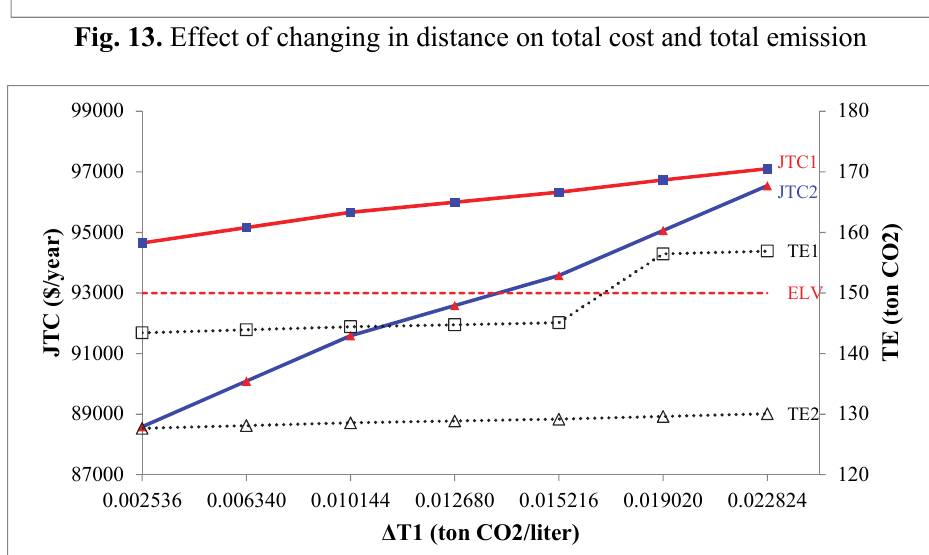
Fig. 14. Effect of changing in transport indirect emission factor on total cost and total emission